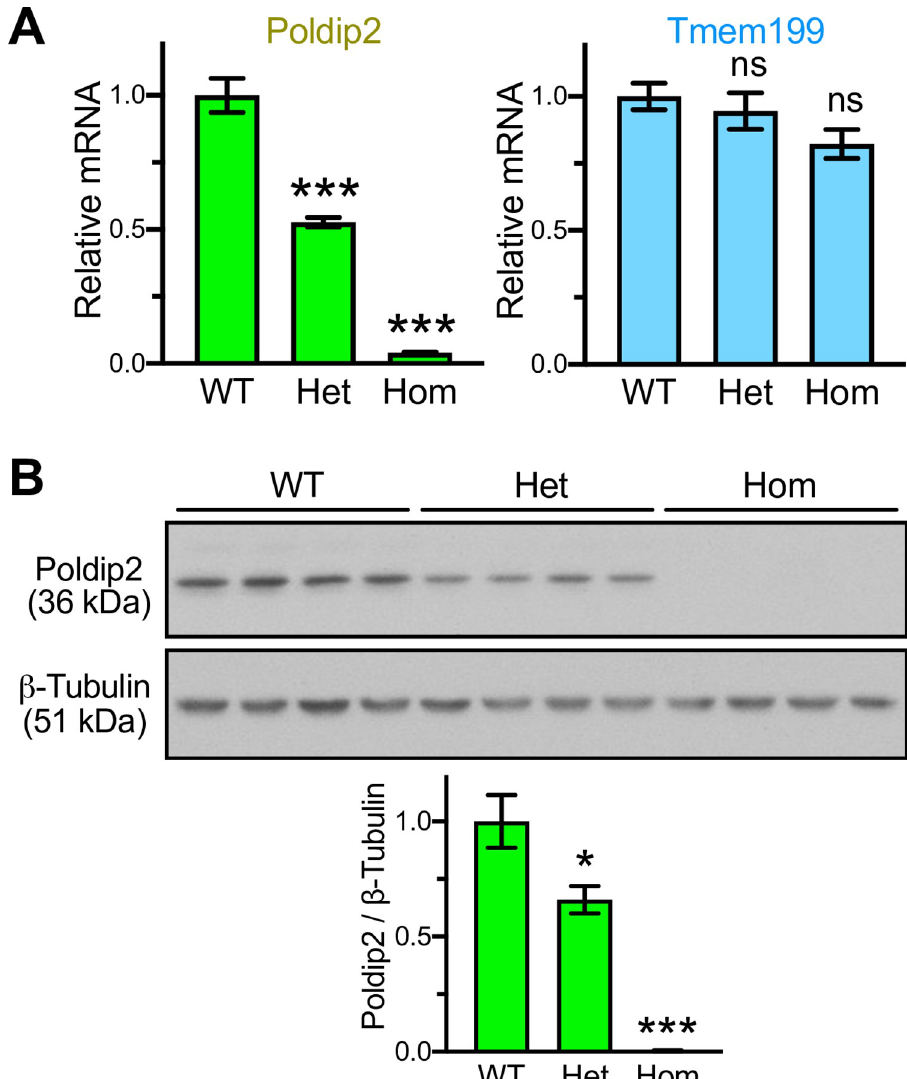
Fig 7. The excised Poldip2 allele is null and does not affect Tmem199 expression. Gene expression was measured in liver samples from mice with indicated genotypes. Bar graphs represent m ± SEM (n = 4 mice in each group). A: Poldip2 (left) and Tmem199 (right) mRNA expression was measured by qPCR. ��� P < 0.001 and ns P > 0.05, vs. WT. B: POLDIP2 and β -TUBULIN protein expression was assessed by Western blotting (top, each lane represents a different mouse) and quantified by densitometry (bottom). � P < 0.05 and ��� P < 0.001, vs. WT. The absence of POLDIP2 protein expression in Hom mice indicates that they are complete